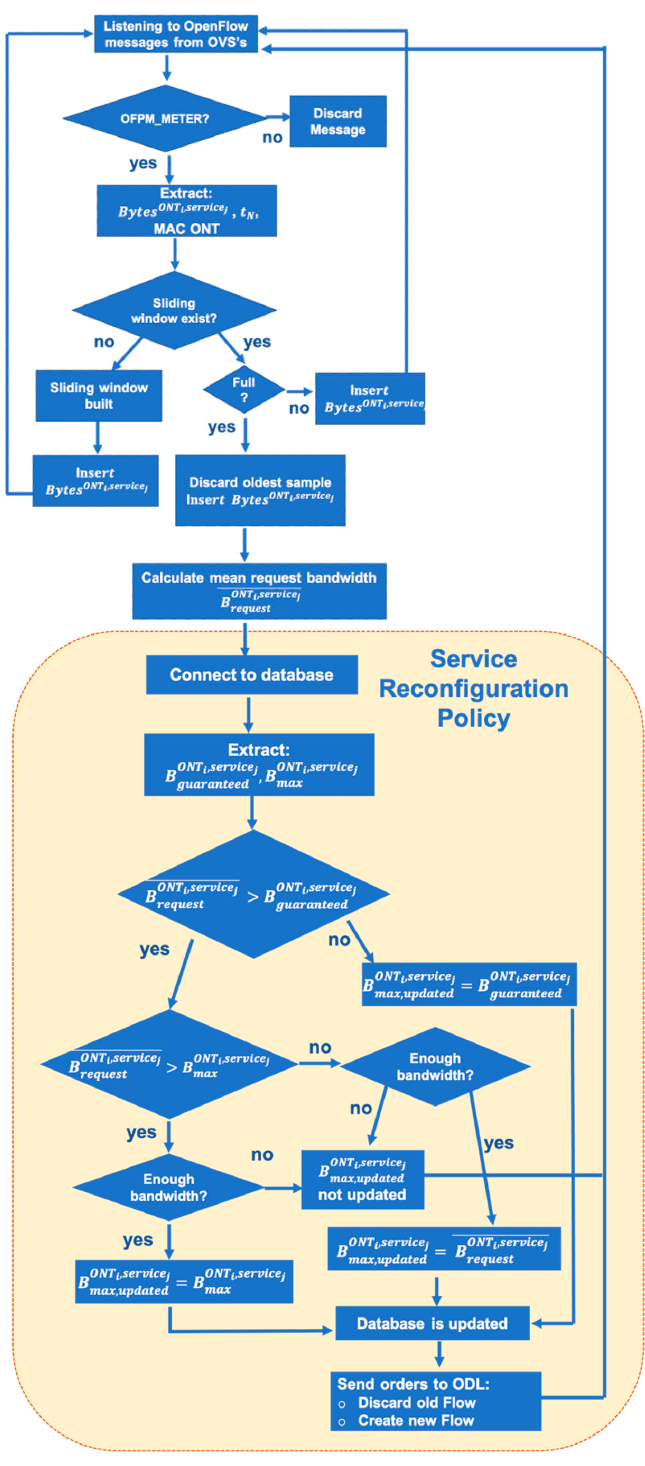
Figure 4. Flow chart of the implemented service reconfiguration policy.